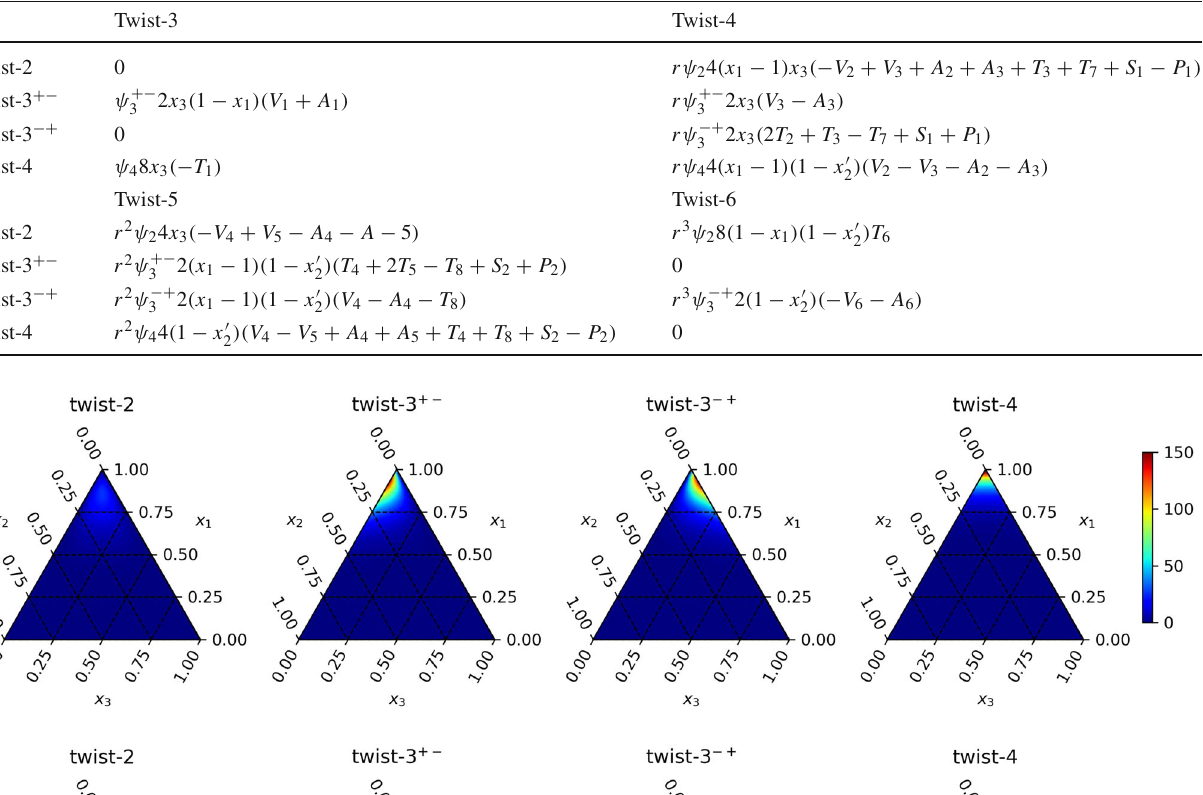
√ /( 64 f (cid:2) 2 N 2 c ) with the color factor C = 8 / 3 is implicit for the entries b b